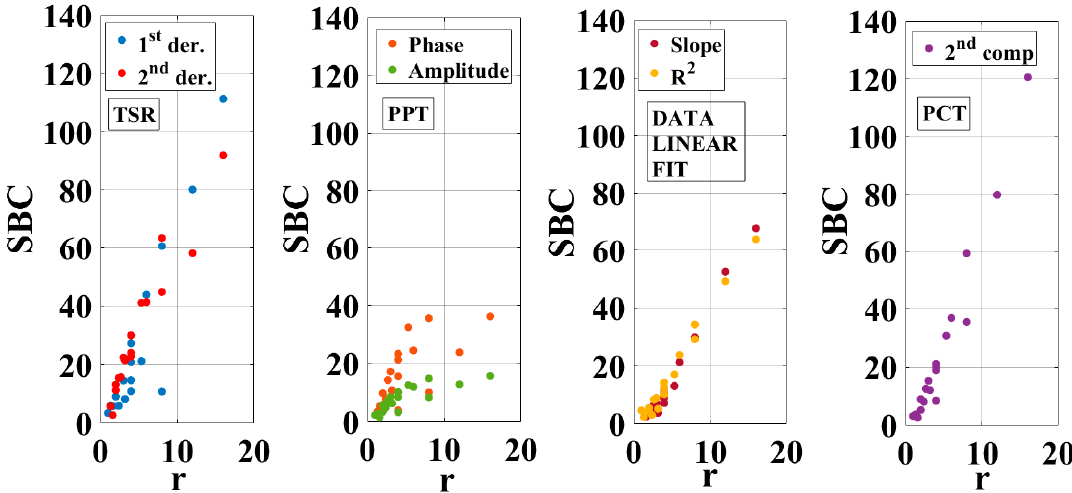
Figure 10. Comparison of different algorithms in terms of maximum SBC.